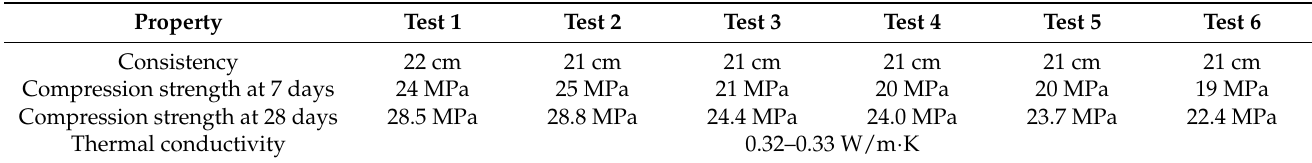
Table 13. Results of insulating refractory concrete for lab tests.